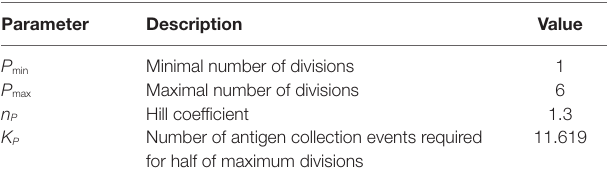
TaBle 1 | Parameters and values for the affinity-dependent number of B cell divisions (DnD).